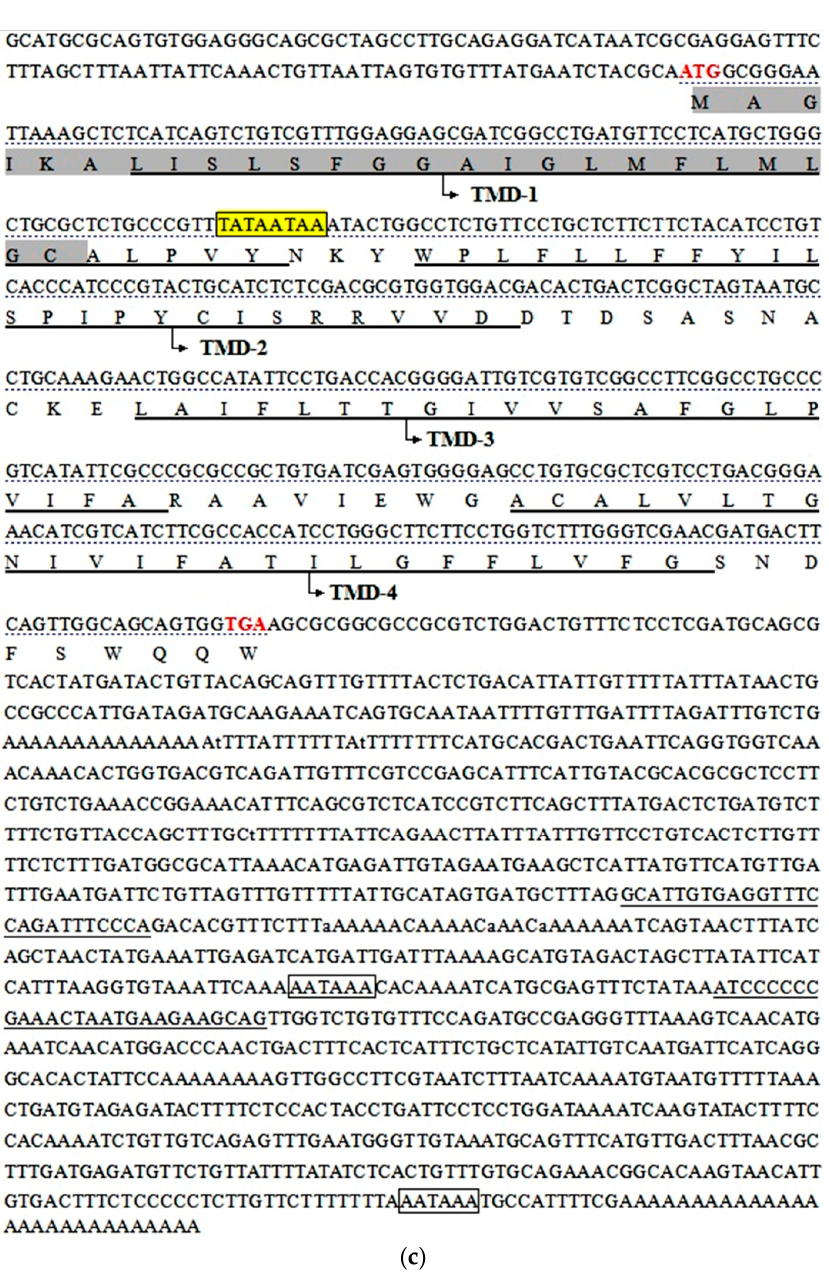
Figure 1 ． Nucleotide and deduced amino acid sequences of M. amblycephala leptin ( a ); leptinR ( b ); and leprotl1 ( c ). The open reading frame (ORF) were underlined; the start and stop codons were bold and red; the signal peptide sequence were red underlined and marked; the transmembrane domains were underlined and marked with transmembrane domain (TMD); the conserved site sequences were boxed and shaded; the deduced amino acid sequences of fibronectin type-III domain profiles of leptinR were filled in gray and a conserved motif (WSXWS) in leptinR was boxed and shaded; predicted amino acid sequence of prokaryotic membrane lipoprotein lipid attachment site profiles in leprotl1 were filled in gray. The TATA boxes and conservative motif have been highlighted in yellow, the transcription factor “CCAAT” was marked in blue.